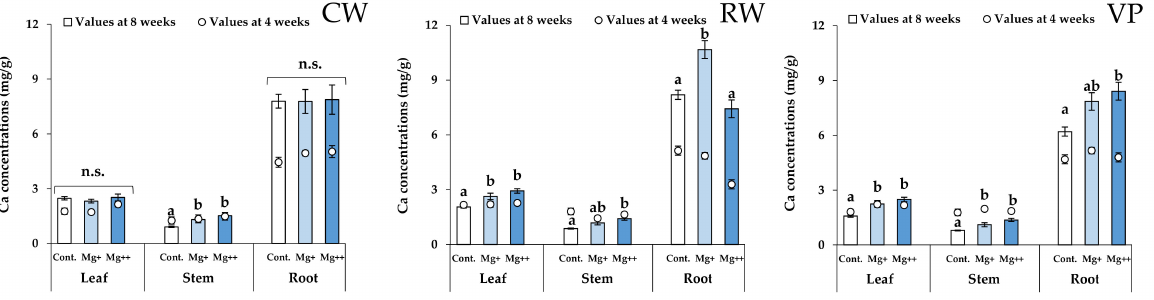
Figure 4. Ca concentrations of leaf, stem, and root in each treatment group and each cultivar at 4 (scatter plots) and 8 weeks (bar graph). Data are means ± SE. Significant differences among means are indicated by different letters. n.s. represents no significant differences among the treatment groups.